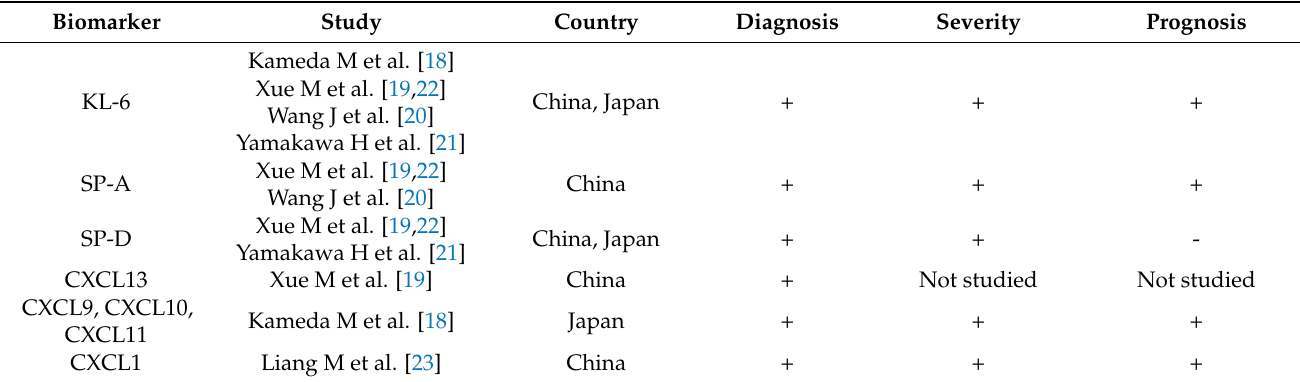
Table 2. Circulating biomarkers associated with pulmonary fibrosis in